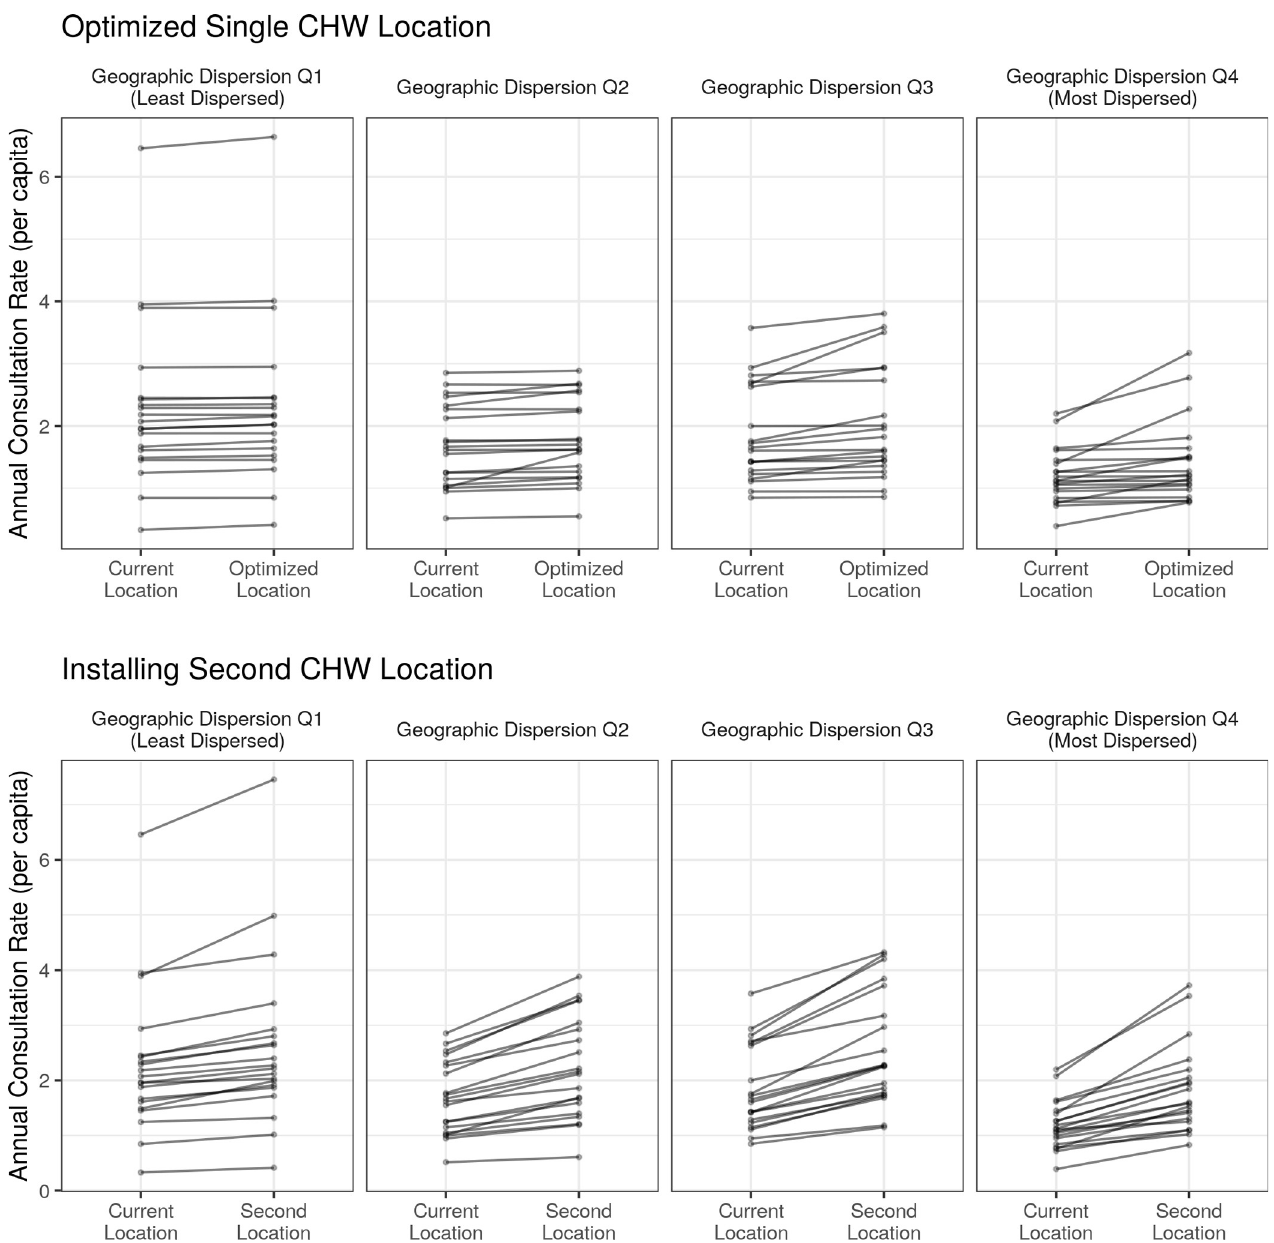
Fig 4. Both proposed solutions have the strongest predicted improvement in consultation rates in the most geographically dispersed fokontany. The predicted change in annual CHW consultation rates following the optimization of a single CHW site (top row) or the addition of a second CHW site in an optimized location (bottom row). Each line represents the predicted change for one fokontany and fokontany are grouped into quartiles determined by their geographic dispersion estimates (Q1: least dispersed, Q4: most dispersed).